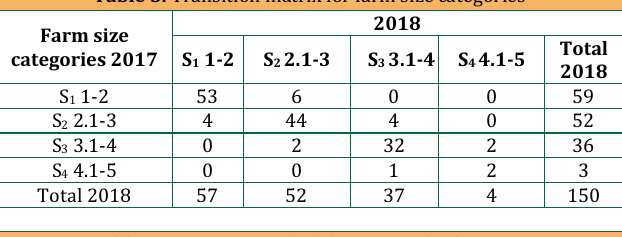
Table 6: Transition probability matrix for farm size Farm